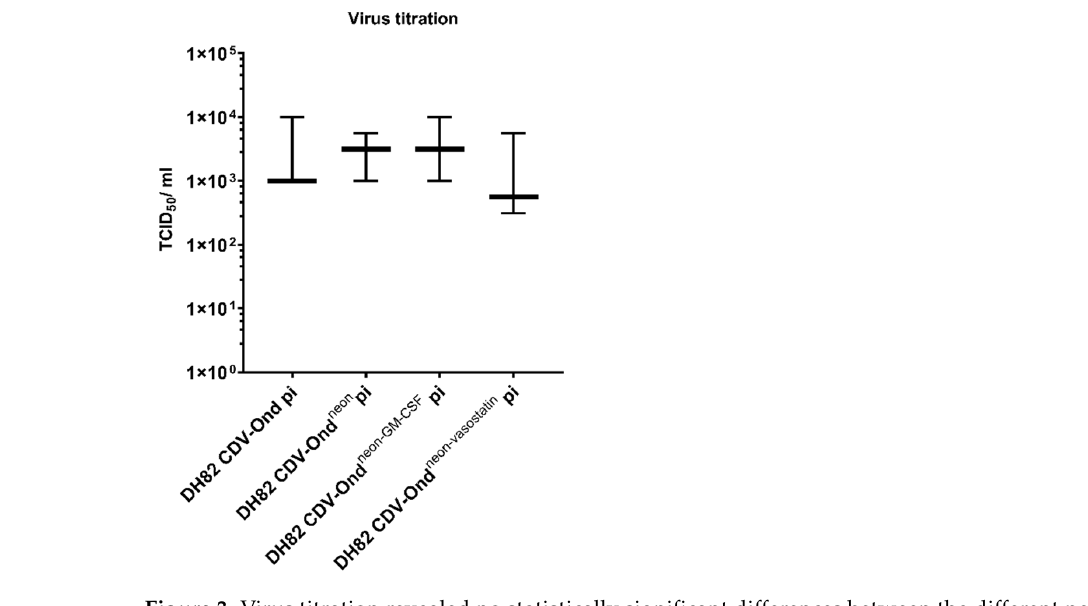
Figure 3. Virus titration revealed no statistically significant differences between the different persis- tently infected cell lines (Mann–Whitney-U test; p > 0.05). Box plots represent minimum, median and maximum.